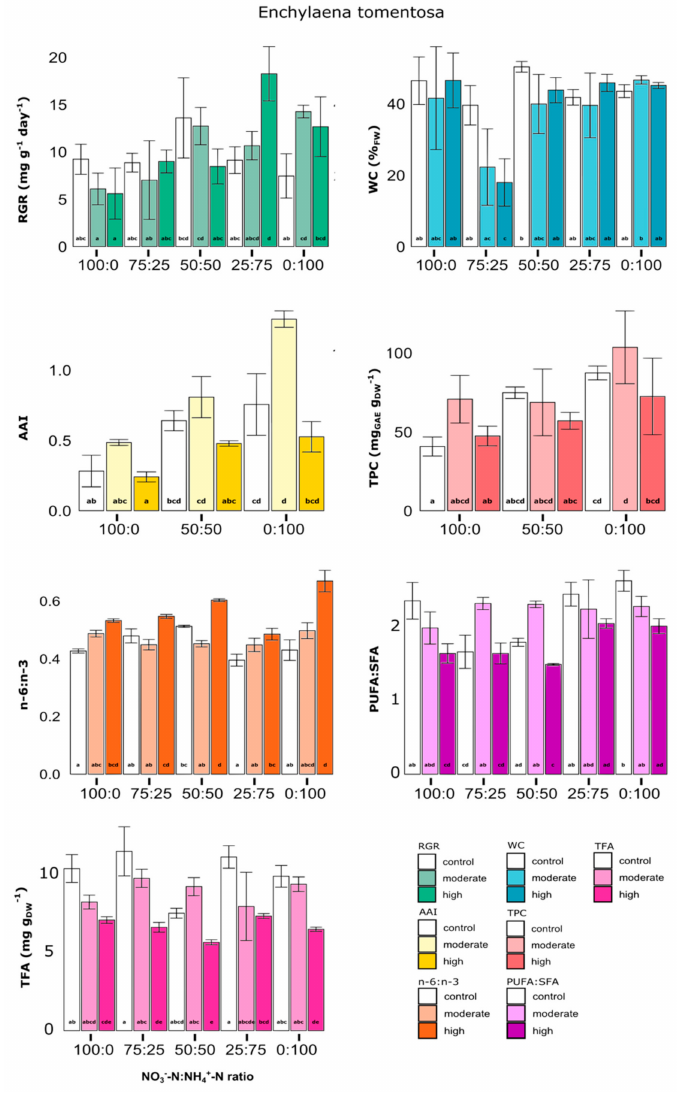
Figure 3. Multiple comparisons of relative growth rate (mg g − 1 day − 1 ), water content (% FW ), antioxidant activity index (AAI), total phenolic compound (TPC) content (mg GAE g DW − 1 ), total fatty acid (TFA) content (mg g DW − 1 ), ratio of polyunsaturated on saturated fatty acids (PUFA:SFA) and ratio of omega 6 on omega 3 fatty acids (n − 6:n − 3) in Enchylaena tomentosa between combined treatments of salinity and N-ratio in irrigation water. For each variable, values with the same letters are not significantly different between treatments ( p < 0.05). Data are mean ± SD ( n =